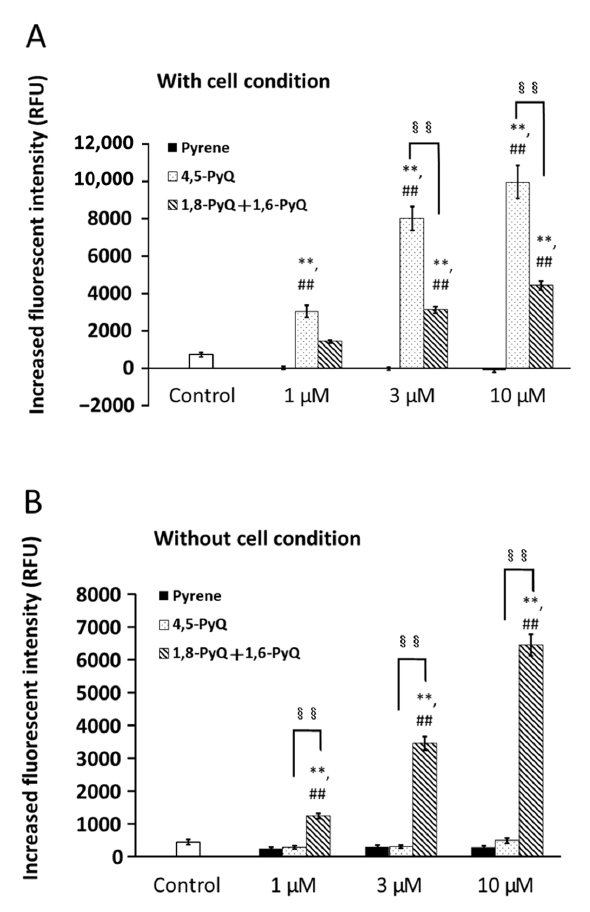
Figure 4. Effects of pyrene and its quinone forms on reactive oxygen species (ROS) production by airway epithelial cells. The intracellular (with cell condition) ( A ) and extracellular (without cell conditions) ( B ) ROS production during 3 h exposure. The data are expressed as the mean ± standard error of the mean (SEM) from four individual cultures. ** p < 0.01 vs. control, ## p < 0.01 vs. pyrene at the same concentration, §§ p < 0.01 vs. each other.